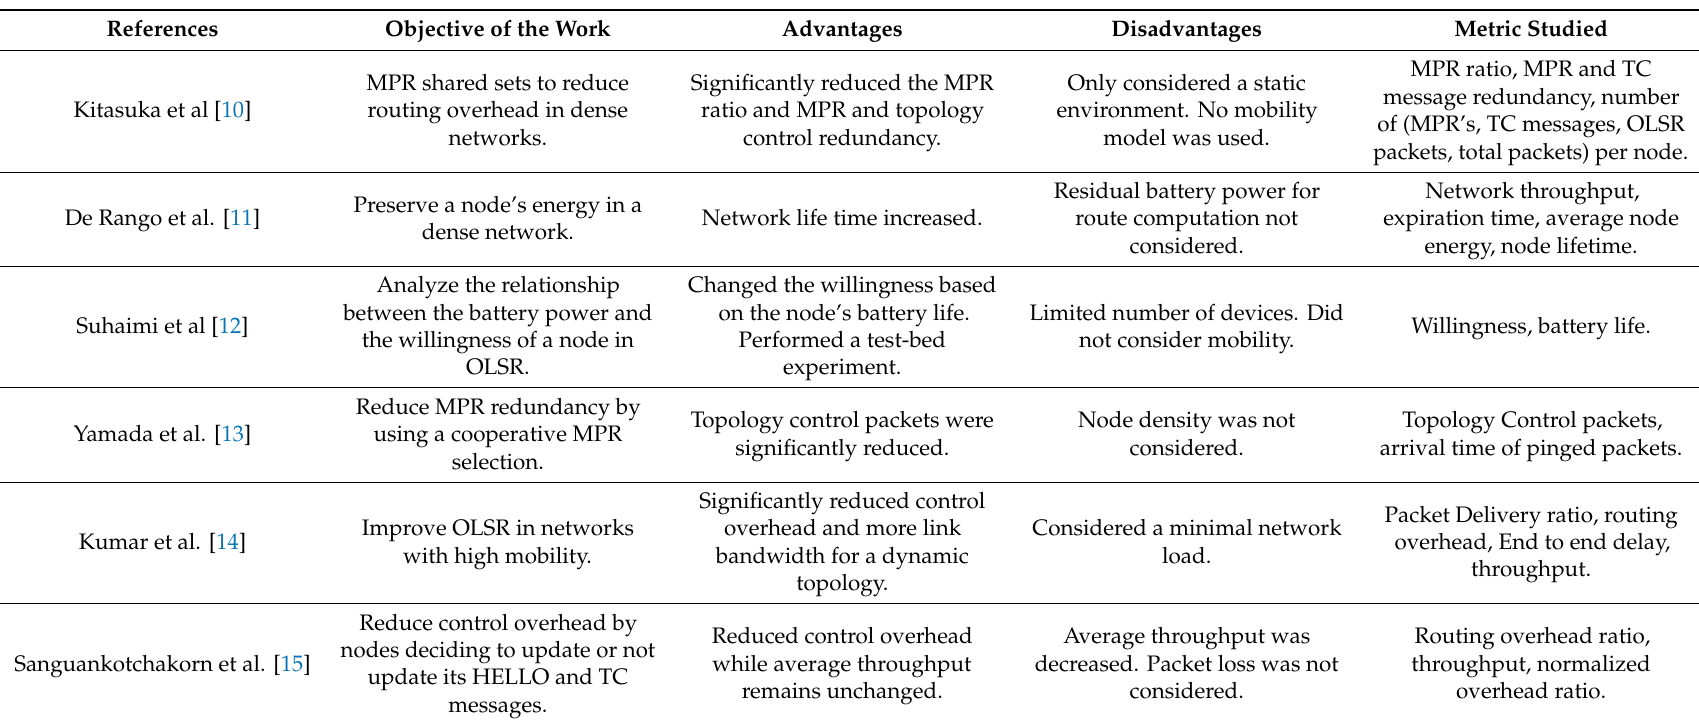
Table 1. Comparative study of related